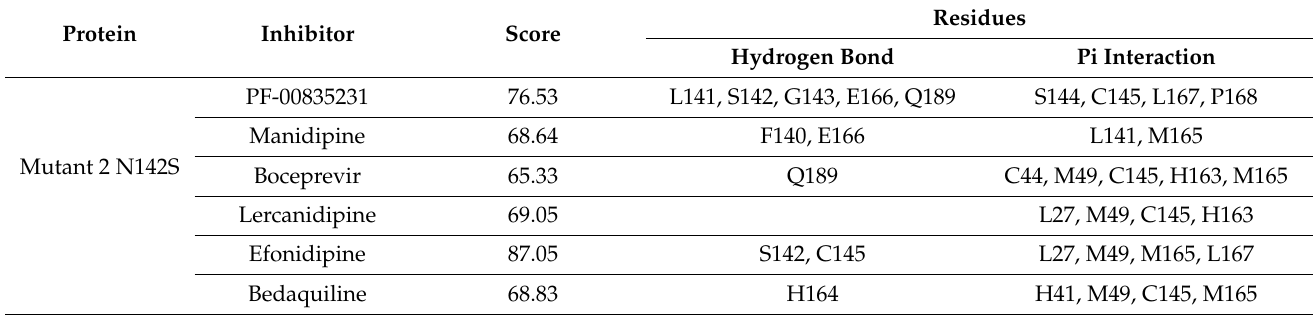
Table 3. The binding details of all compounds against the Mutant 2 (N142S) Mpro.